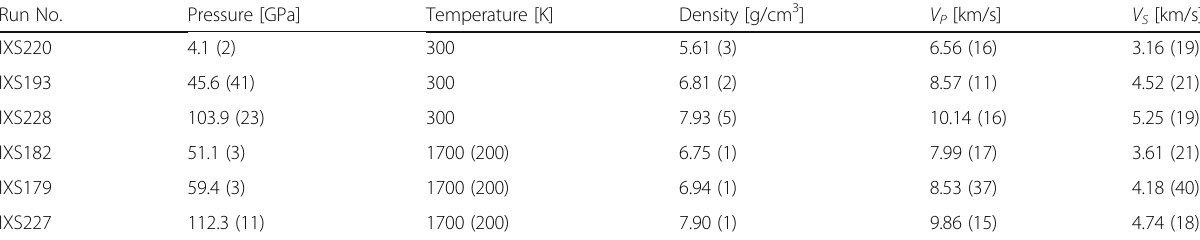
Table 2 Experimental conditions and results of this study Run No.